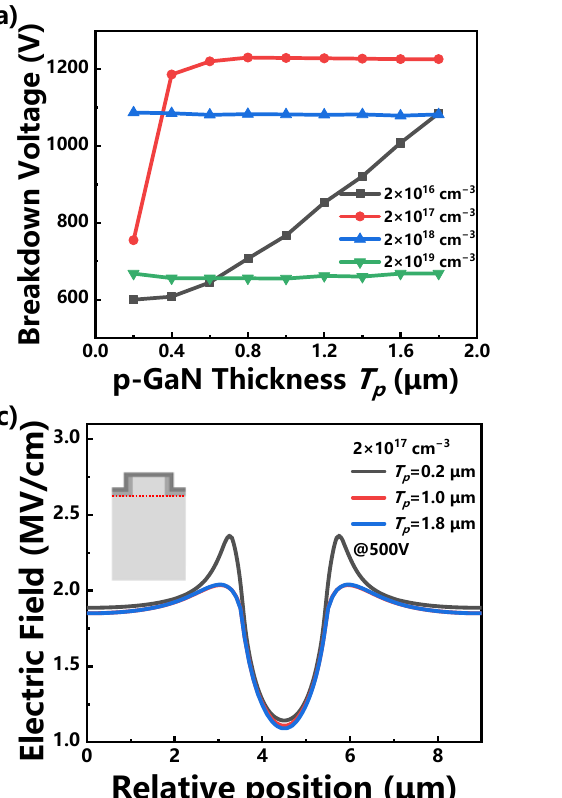
Figure 5. ( a ) Breakdown voltage of TJBS diodes with different p-doping concentrations as a function of p-GaN thickness. When the drift layer concentration is 2 × 10 16 cm − 3 , for different p-GaN thicknesses, the electric field profiles at 500 V along ( b ) the horizontal interface between metal and p-GaN and ( c ) the bottom of p-GaN correspond to p-doping concentrations of 2 × 10 16 cm − 3 and 2 × 10 17 cm − 3 , respectively. ( d ) Electric field profiles at 500 V along the bottom of p-GaN for different p- GaN thicknesses when the p-doping concentration is 2 × 10 18 cm − 3 .